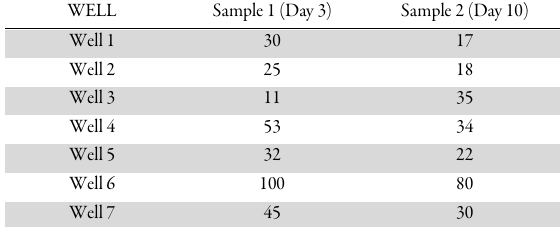
Table 4. Total faecal coliform counts for water samples (n x 104 cfu/ml) WELL